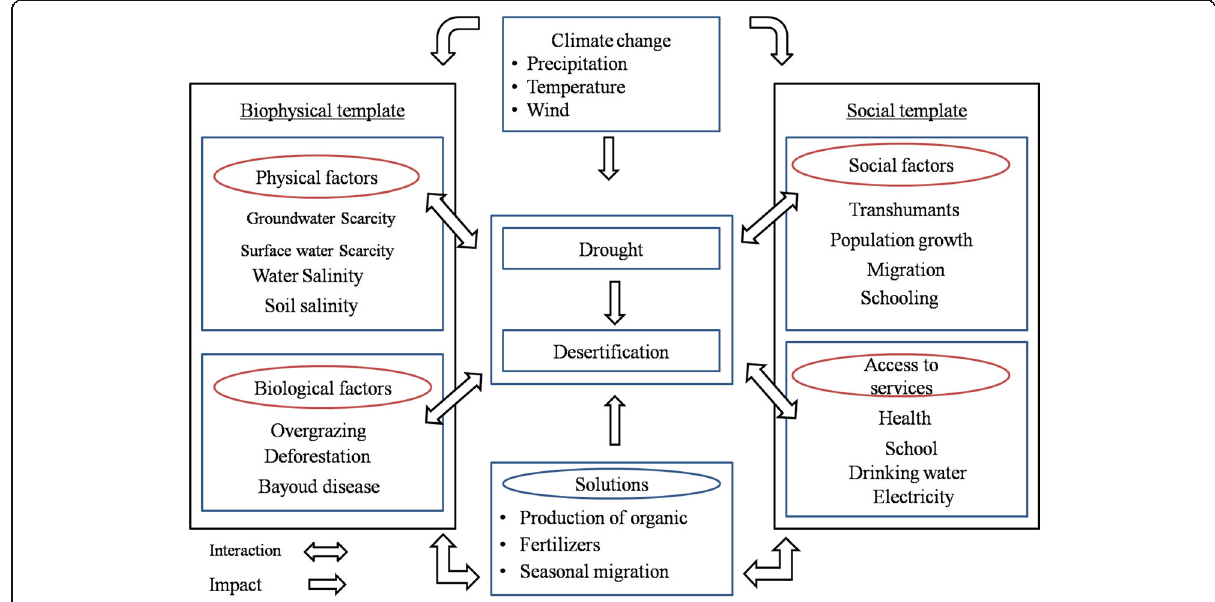
Fig. 2 Community-based risk reduction Framework identifying the indicators and their